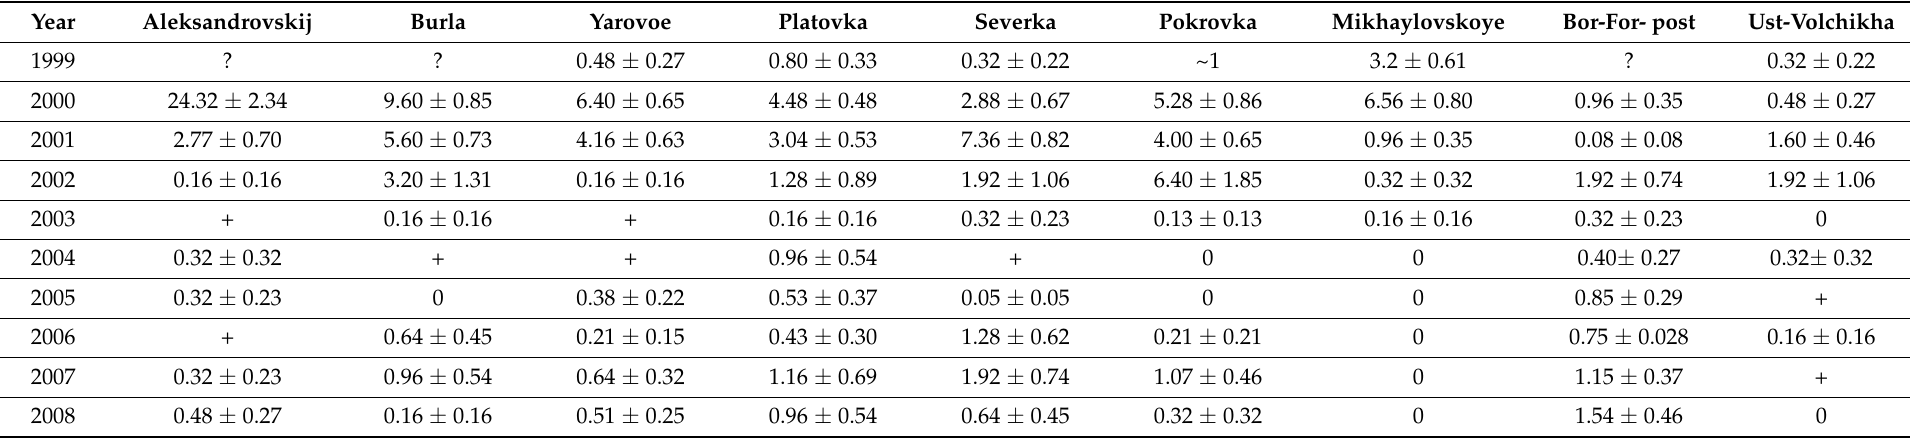
Table 1. Dynamics of the average densities (ind. per m 2 ± s.e.) of the Italian locust in the Kulunda steppe.